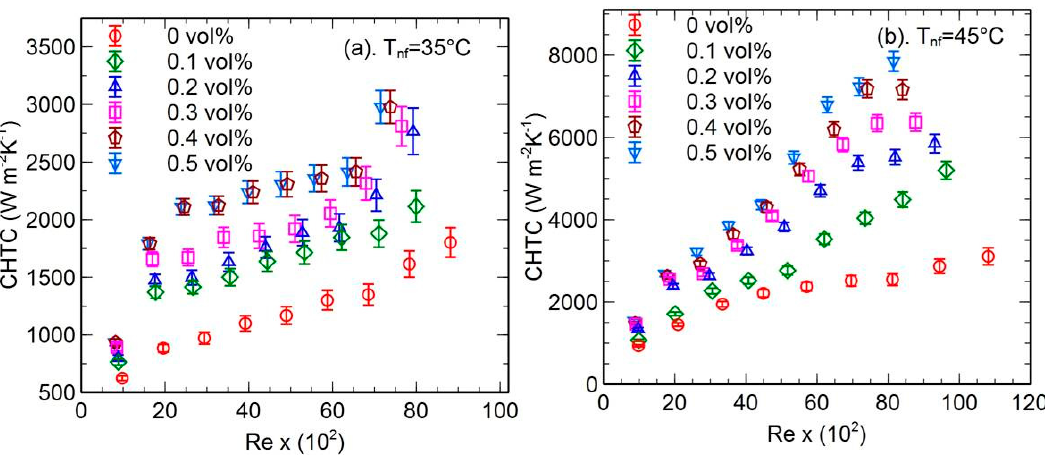
Figure 6. Variation of CHTC in a tube in tube heat exchanger